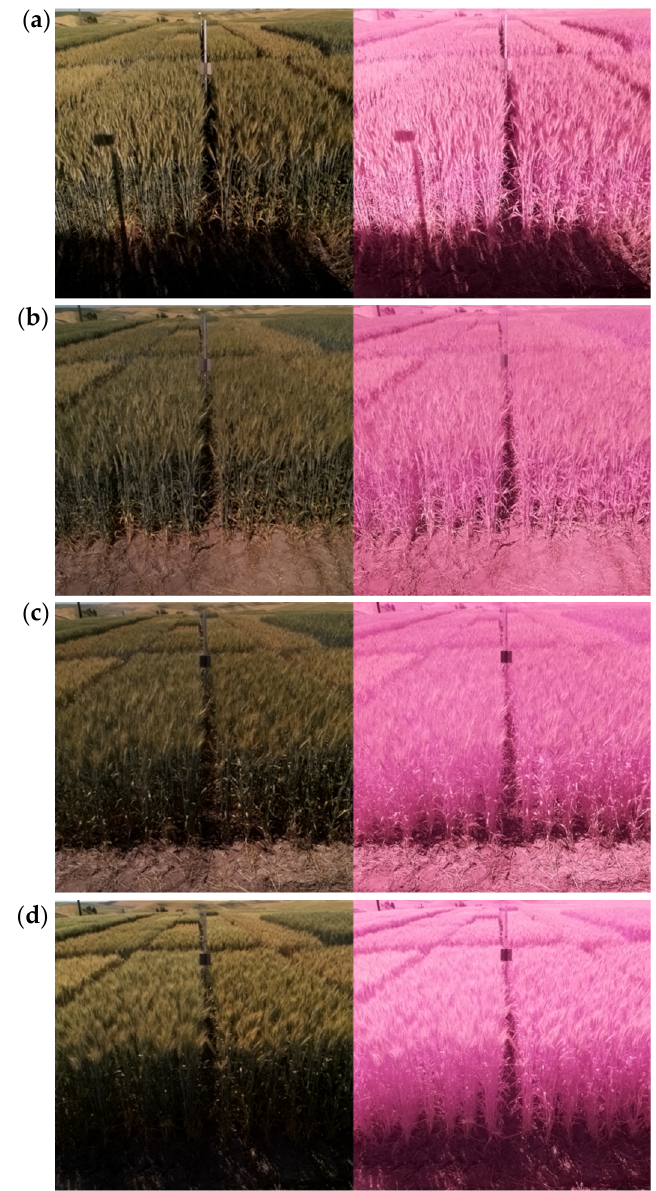
Figure 6. Images from a sample sensor system on 18 July 2020 consisting of the images from RGB and NoIR cameras in one screen captured at ( a ) 7.30, ( b ) 10.30, ( c ) 13.30, and ( d ) 16.30 h.